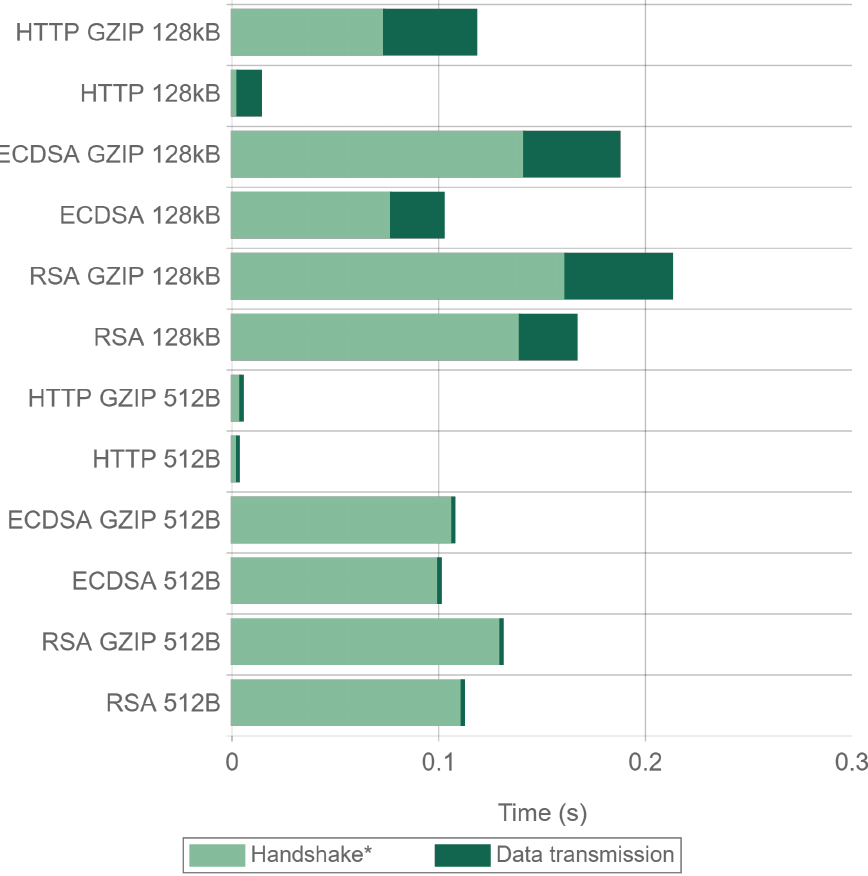
Figure 21. Handshake and payload communication times for 512-byte and a 128-kilobyte payloads using Elliptic Curve Digital Signature Algorithm (ECDSA), Rivest–Shamir–Adleman (RSA), and HTTP, with and without GNU ZIP (GZIP) compression using Apache2. * HTTP handshake for HTTP, Transport Layer Security (TLS) and HTTP handshakes for ECDSA and